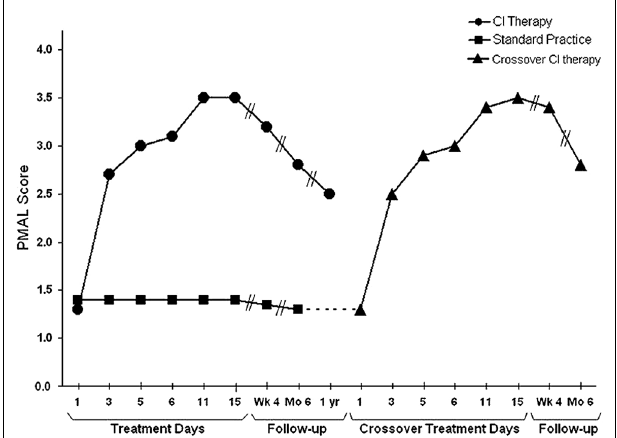
FIGURE 4 | Spontaneous use of the more impaired arm (Pediatric MotorActivity Log score) of young (2–6 years) children with hemiparetic CP receiving Constraint-Induced Movement therapy or standard occupational therapy. Data for the Constraint-Induced Movement therapy group are shown before and during treatment and 1, 6, and 12 months after treatment. Data for the control subjects are shown at corresponding times for 6 months after treatment, at which time they were crossed over to Constraint-Induced Movement therapy. After crossover data are shown for treatment and 1 and 6 months afterward.The data are similar to those for adults shown in Figure 1 . For both the children given CI therapy first and those given the intervention after crossover, the amount of spontaneous use of the more affected arm in the ADL in the real-world environment increased from approximately 15% compared to use of the less affected arm to approximately 65%. Reprinted fromTaub etal. (2011).